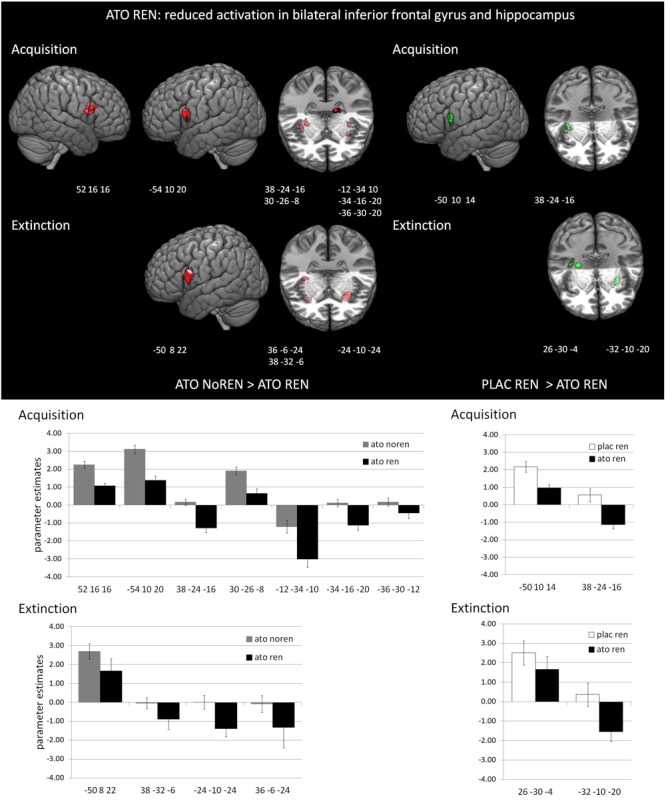
Reduced activation in ATO REN compared to ATO NoREN and PLAC REN (contrasts ATO NoREN > ATO REN; PLAC REN > ATO REN, SVC p < 0.05 FWE-corrected). The bar graphs represent the parameter estimates for the subgroups regarding the differentially activated regions: relative to the other groups, ATO REN shows a less prominent activation increase in iFG, and predominantly deactivation relative to baseline in hippocampus.